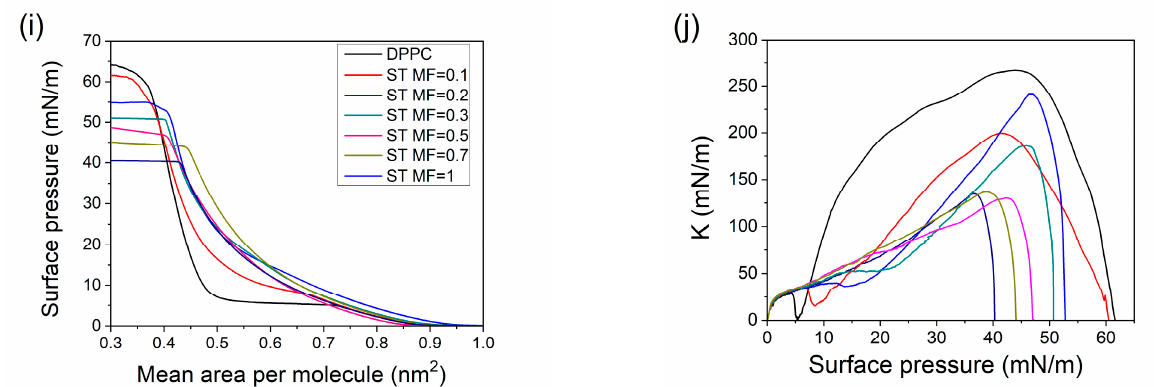
Figure 3. Surface pressure–mean molecular area ( π -A) ( a , c , e , g , i ) and compressibility (K- π ) ( b , d , f , h , j ) isotherms for mixture of DPPC and: ( a , b ) Toc; ( c , d ) CT; ( e , f ) OT; ( g , h ) MT; ( i , j ) ST. Molecular fraction (MF) of components is given in the legend. All π -A and K- π isotherms for different MF of Toc were obtained at pH 3. All presented plots for CT and investigated esters were collected at pH 7.